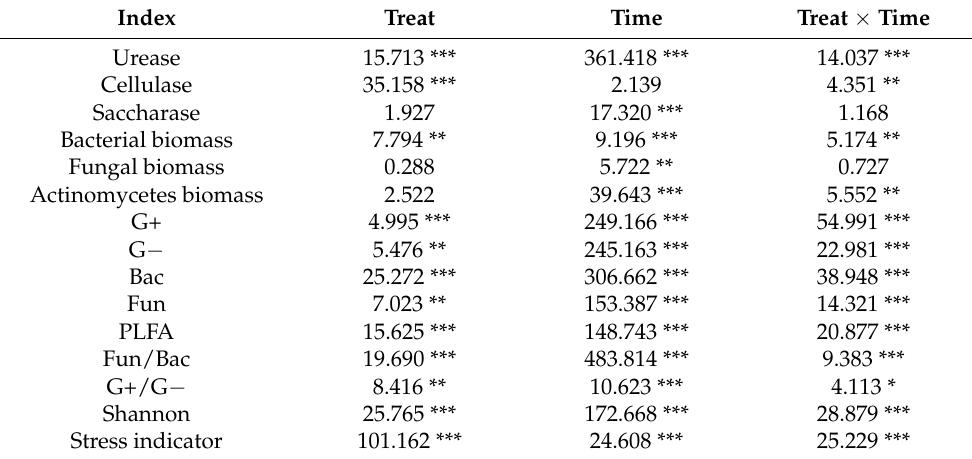
Table 1. Results of the repeated measures analysis of variances, the significance of atrazine treatment and recovery time on soil enzyme activity, and microbial community properties.